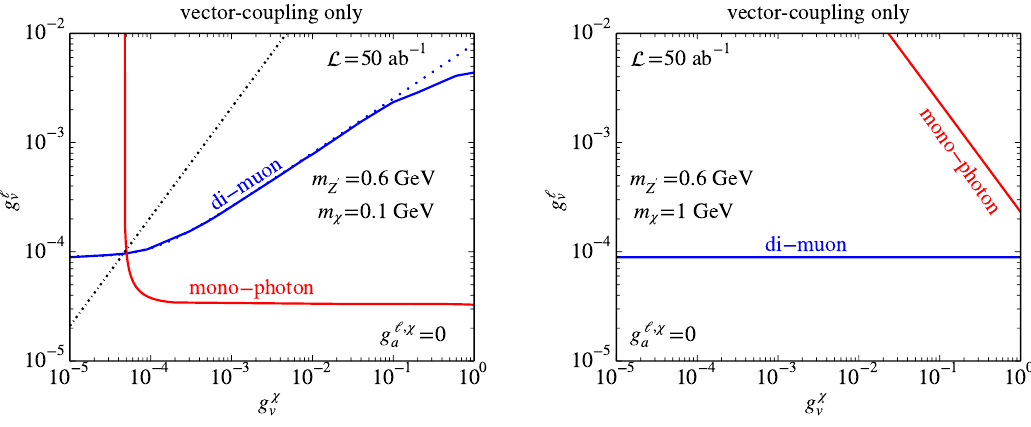
as a function of g χ from v v